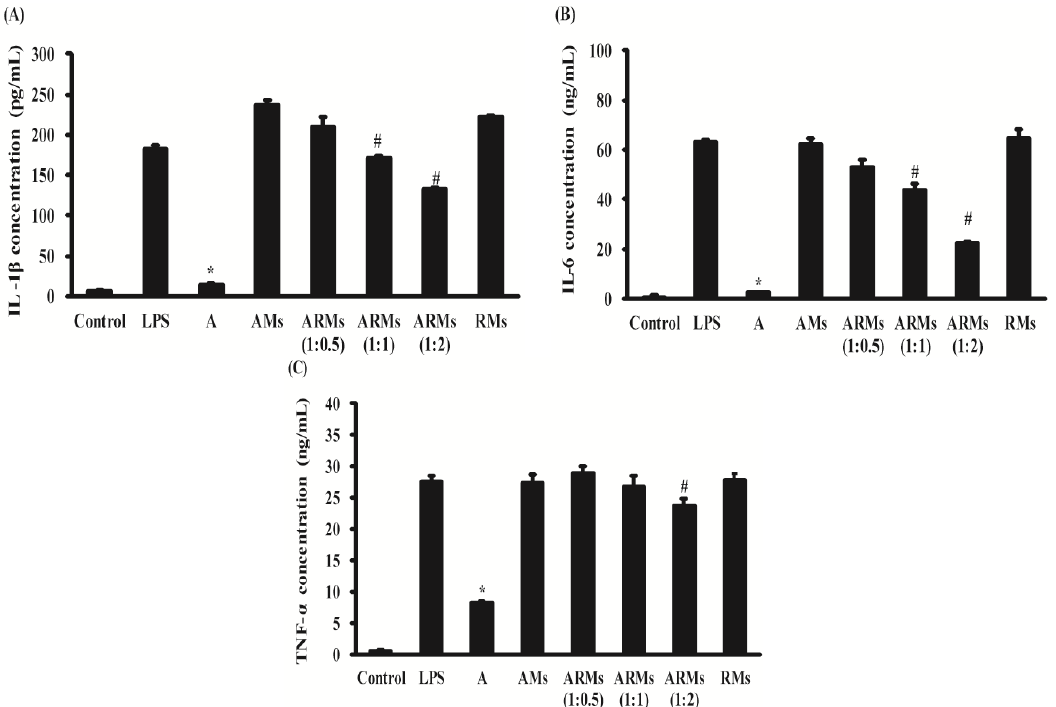
Figure 3. Effects of ARMs on LPS-stimulated IL-1β, IL-6 and TNF-α production in RAW 264.7 cells. The samples of hepatic metabolites were made as described in the Materials and Methods section.